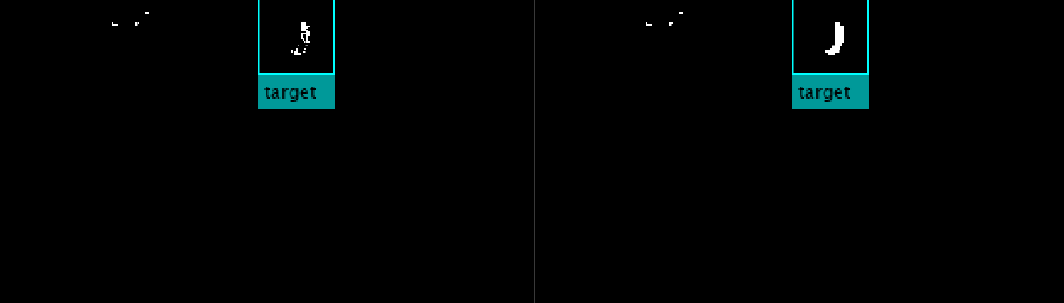
Figure 3. Before and after morphological operations and blob analysis on the binary mask. Left: Same random frame after blue threshold binary mask. Right: Resultant frame after morphological operations and blob analysis.